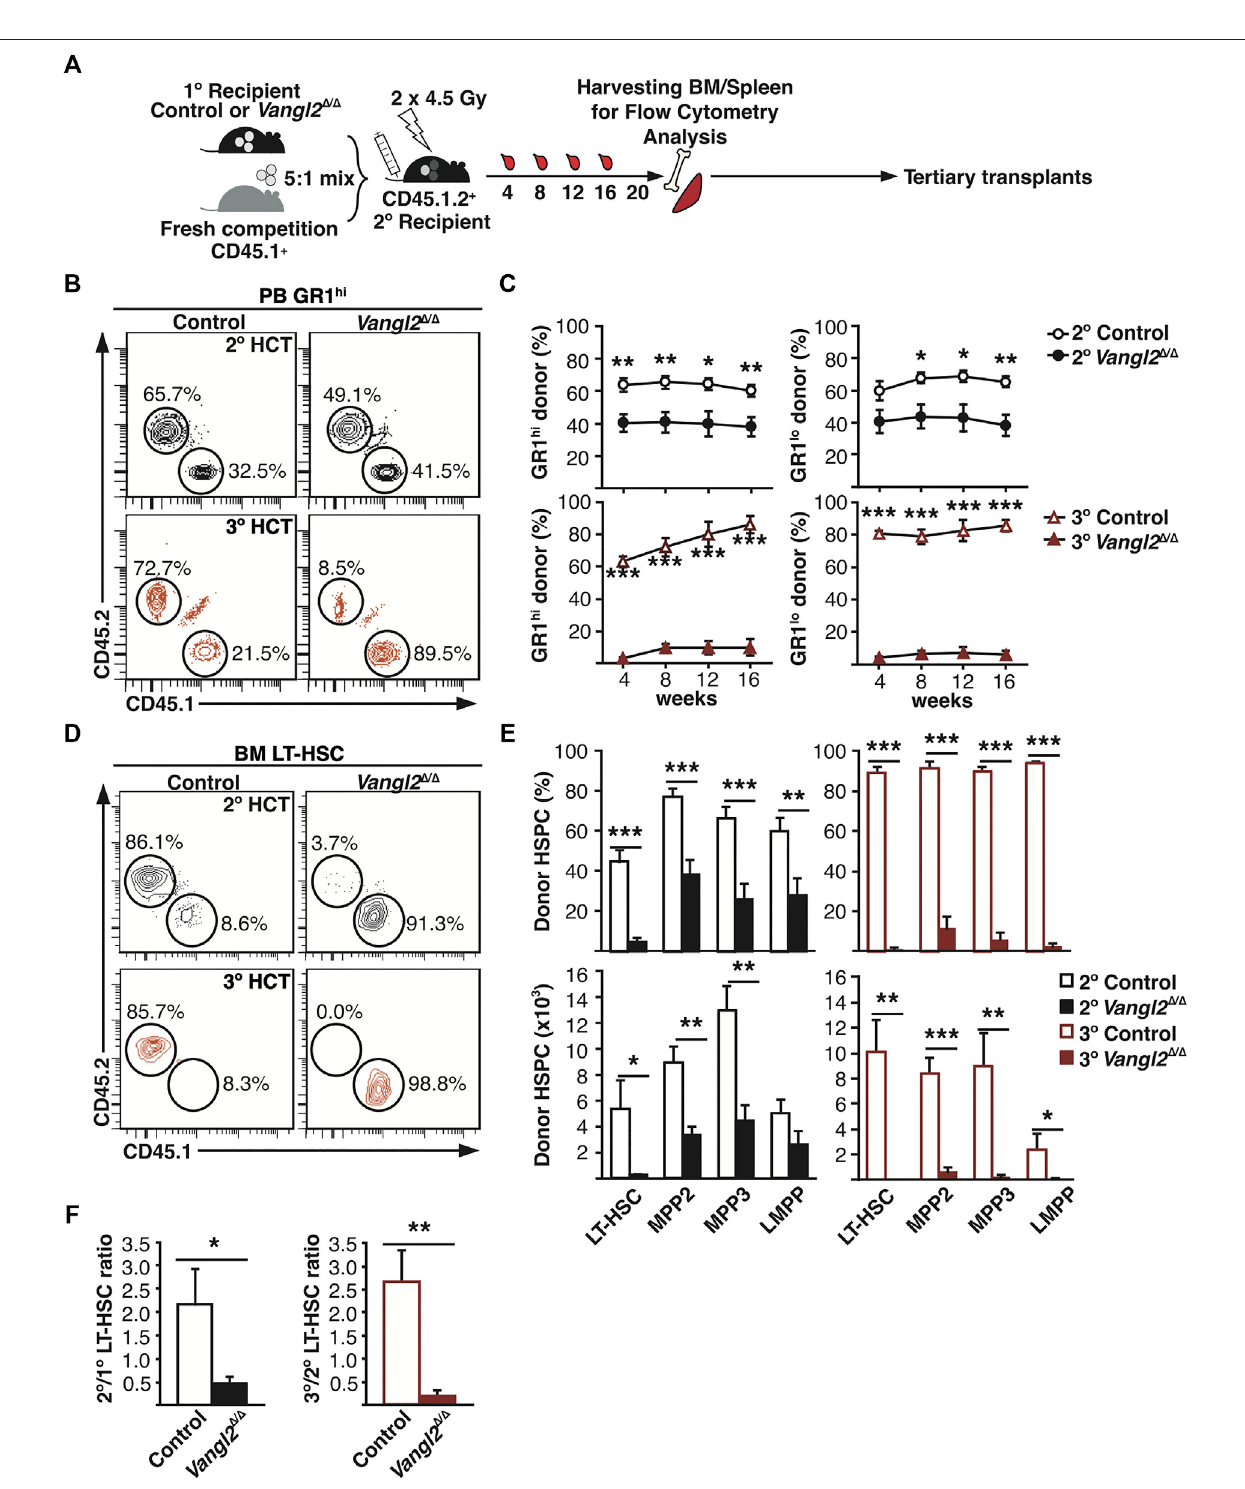
FIGURE 5 | Vangl2 de fi ciency severely impairs hematopoietic recovery in serial transplants, leading to BM failure. (A) Experimental design for serial transplants (B) Representative fl owcytometry datashowingthe percentage ofdonor-derived GR1 hi cellsin secondary and tertiary recipient peripheral blood 16weeks post-transplant. (C) Graphs represent pooled results of donor-derived GR1 hi granulocytes and GR1 lo monocytes in secondary and tertiary recipient peripheral blood (mean +SEM). (D) Representative fl ow cytometry data showing the percentage of CD45.2 + donor-derived or CD45.1 + competitor LT-HSCs in BM of secondary (top panels) and tertiary recipients (bottom panels) 20 weeks post-transplant. (E) Histograms represent donor chimerism or absolute donor-derived cell numbers in secondary/tertiary recipient BM 20 weeks post-transplant (mean +SEM). (F) Donor-derived LT-HSC ratio (post-/pre-transplant) 20 weeks post-transplant. See also Supplementary FigureS2,S3,S4 .* p ≤ 0.05, ** p ≤ 0.005, *** p ≤ 0.0005.Secondarytransplants representtwoindependent transplantgroups(n=9control,10 Vangl2 Δ / Δ ),while tertiary transplants represent one single group (n = 4 control, six Vangl2 Δ / Δ ).